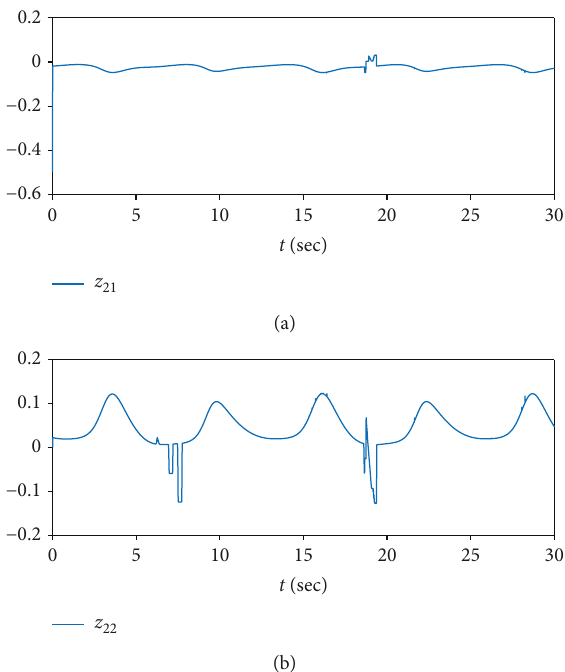
Figure 6: The time response of tracking error z